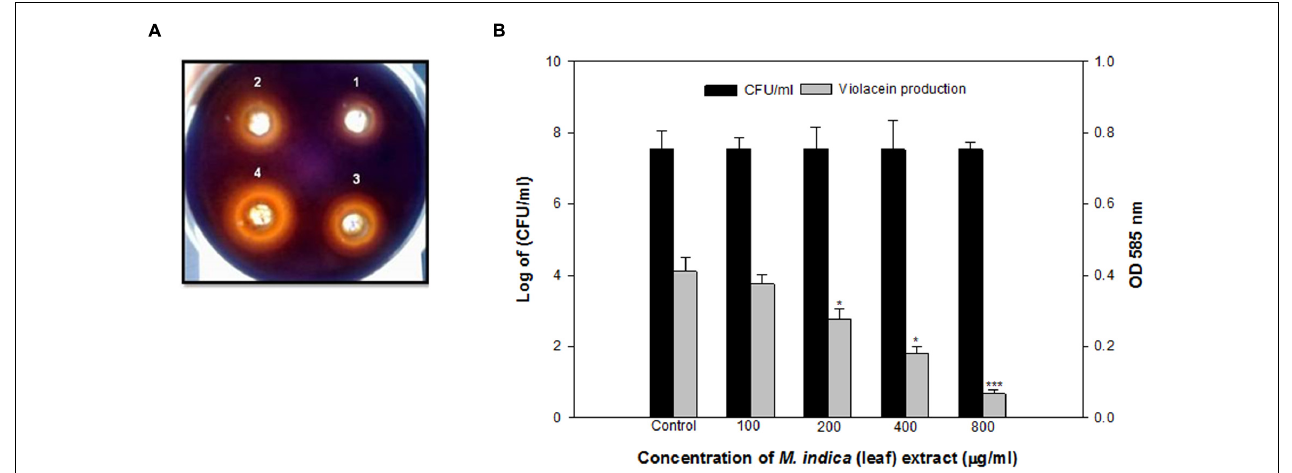
FIGURE 1 | (A) Inhibition of violacein by methanol extract of Mangifera indica (leaf) in C. violaceum at the concentration of 200 (1), 400 (2), 800 (3), and 1600 (4) µ g/ml. (B) Quantitative assessment of violacein inhibition in CVO26 at sub-inhibitory concentrations of M. indica (leaf) extract. All of the data are presented as mean ± standard deviation. ∗ p ≤ 0.05, ∗∗∗ p ≤